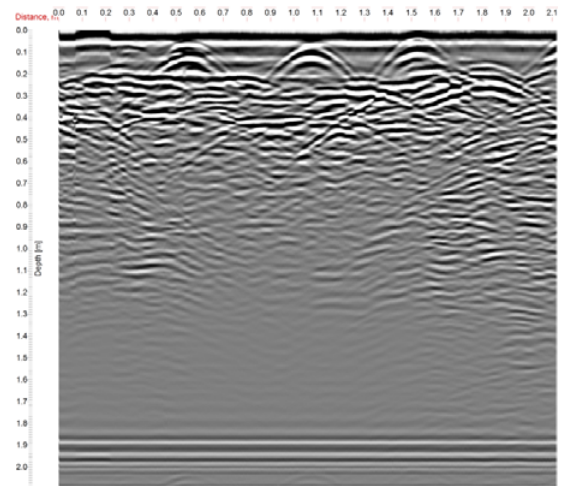
Figure 2: An example of GPR scan used for this